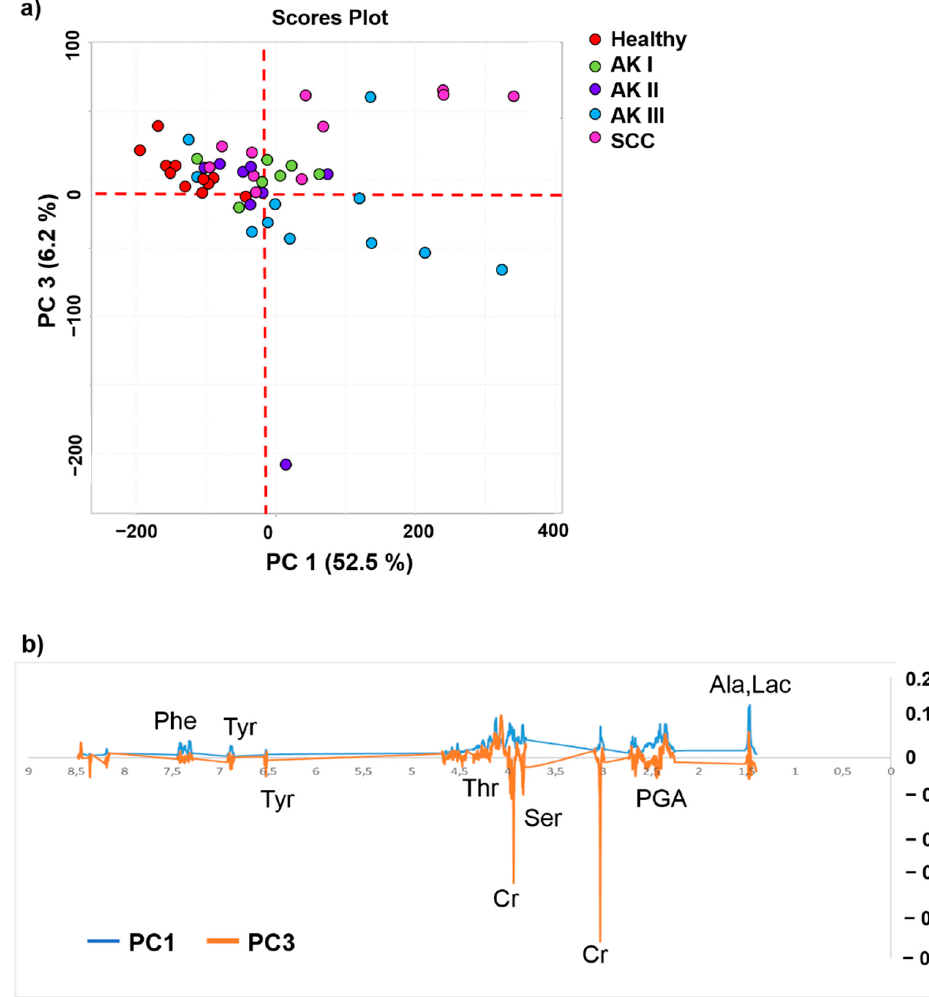
Figure 3. ( a ) PCA scores plot and ( b ) loadings profiles of PC1 and PC3 obtained from the spectral data of the five classes. In ( b ) labelled metabolites: Phe—phenylalanine, Tyr—tyrosine, Thr—threonine, Cr—creatine, Ser—serine, PGA—pyroglutamic acids, Ala—alanine, and